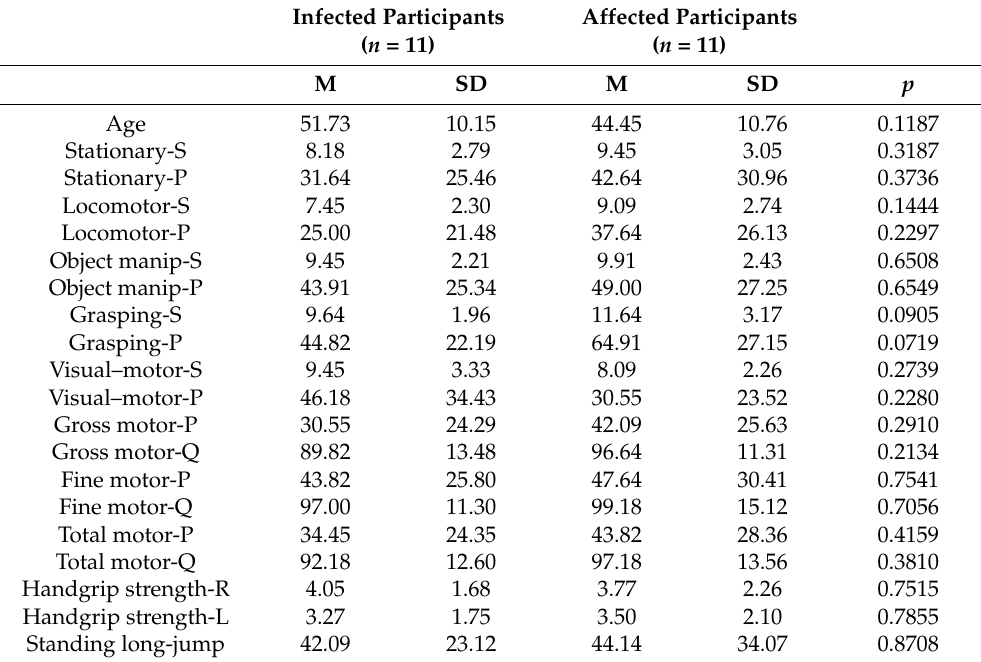
Table 2. Differences between the HIV-infected and affected children before matching them into an intervention and control group. Infected Participants Affected ( n = 11)